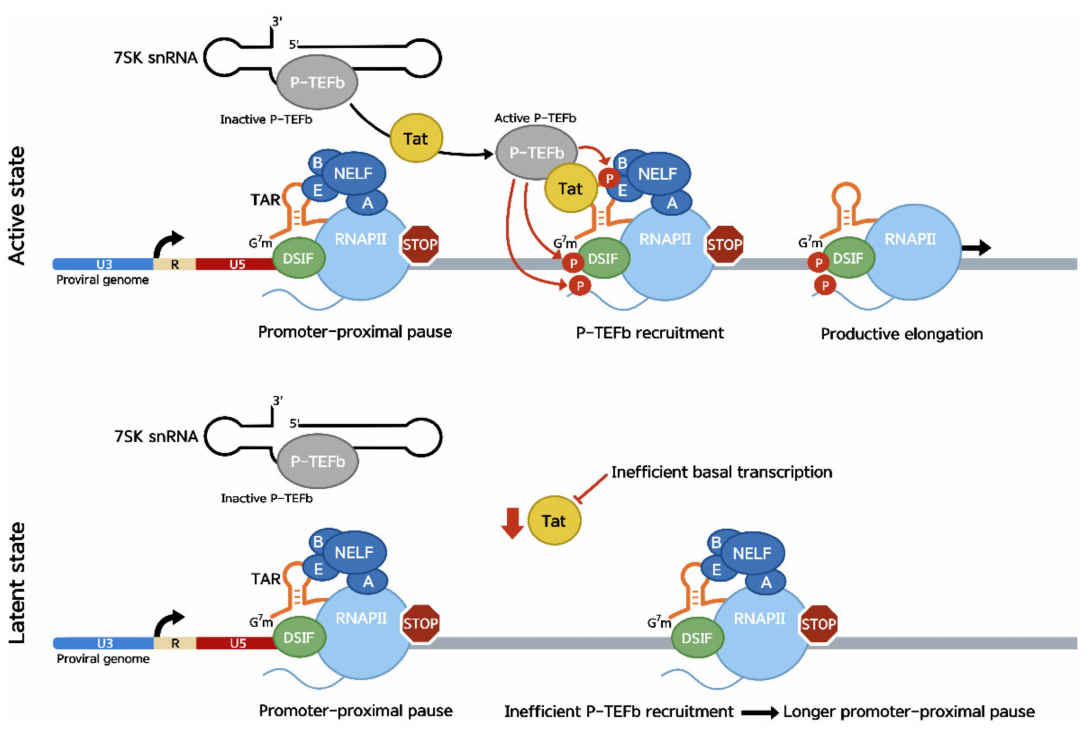
Figure 2. (Active state) Transcription on the provirus is paused shortly after RNAP II transcribes through the TAR element. The interaction between P-TEFb and Tat leads to the activation and dissociation of P-TEFb from the 7SK snRNP, where it is sequestered in its inactive form. Tat-P-TEFb complexes are then recruited to the stalled polymerase through the interaction between Tat and TAR. The kinase subunit of P-TEFb, CDK9, and then phosphorylates Spt5, NELF-E and the RNAP II CTD at Ser2, leading to entry into productive elongation. (Latent state) Low levels of Tat in the infected cell due to insufficient amounts of cellular TFs, promoter mutations and low concentrations of nucleotides impedes basal HIV transcription. Therefore, P-TEFb remains sequestered by 7SK snRNP, and the polymerase remains stalled in a promoter-proximal manner, leading to